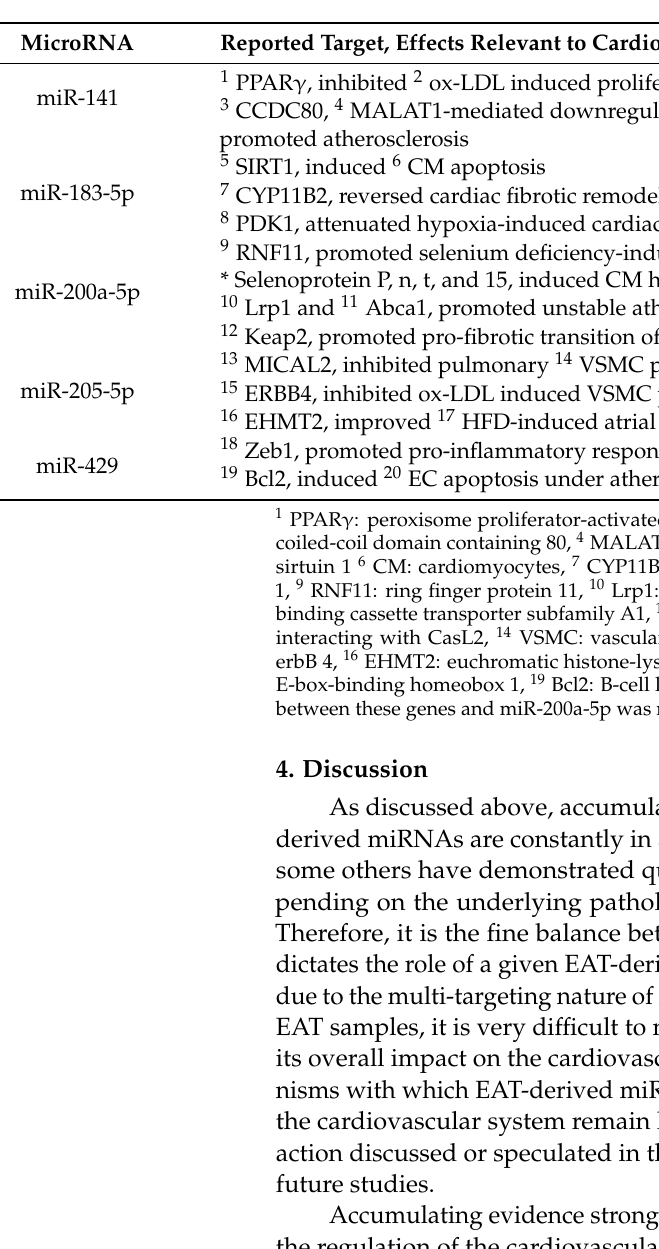
Table 3. EAT-derived exosomal miRNAs increased in CVD